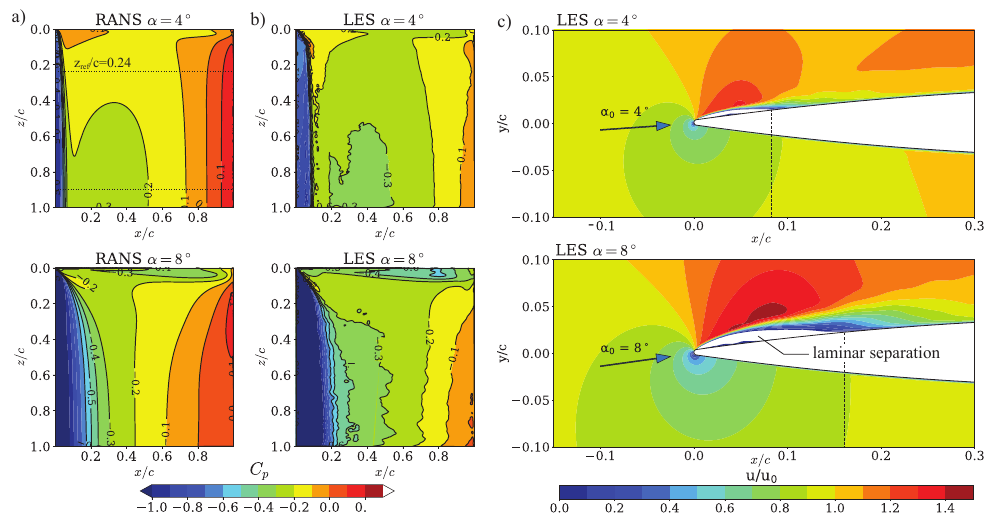
Figure 3. Comparison of RANS and time-averaged LES simulations for α 0 = 4 ◦ and 8 ◦ : ( a ) Surface pressure contours of RANS and ( b ) time averaged LES; ( c ) Leading edge velocity contours of time averaged LES.